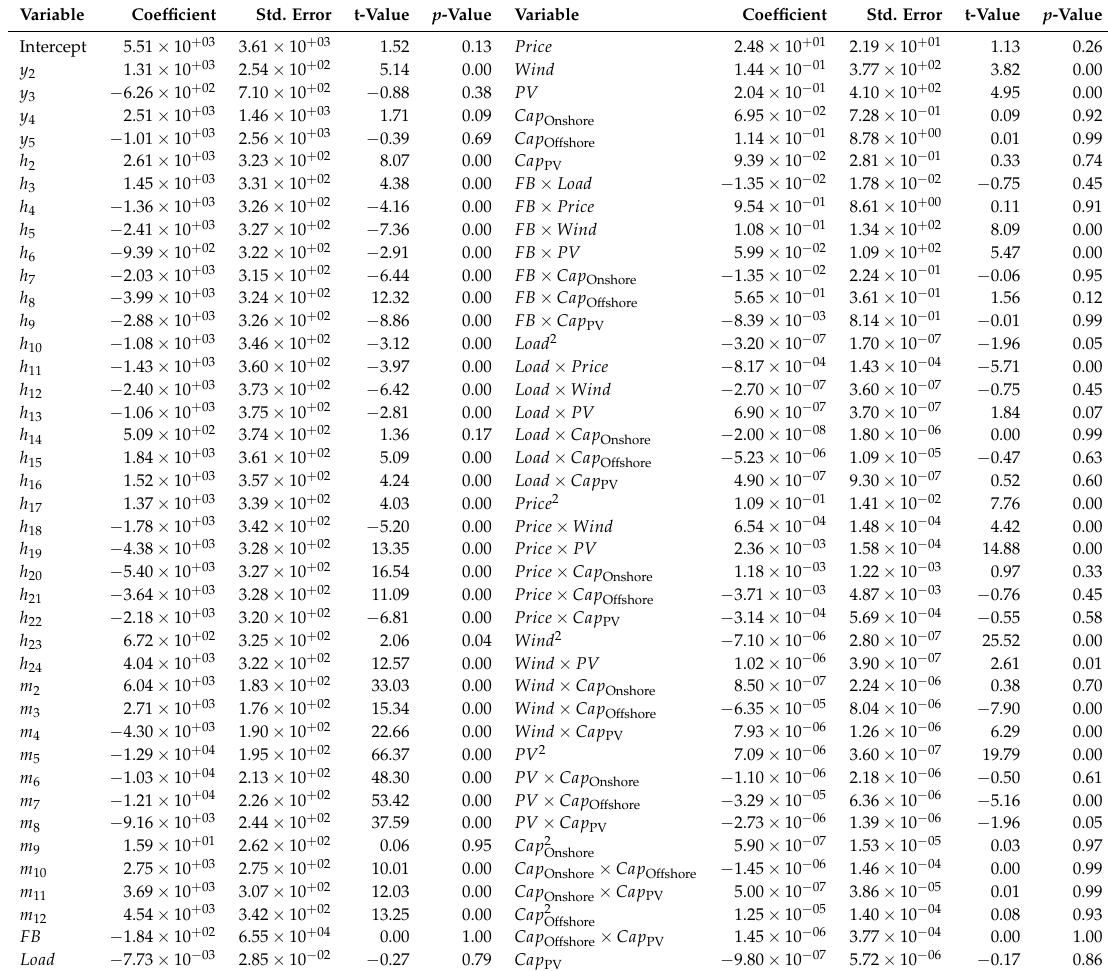
Table A3. Coefficients of the Ridge Regression at an α -level of 200. R-squared: 0.672, Adjusted R-squared: 0.671, F-statistic: